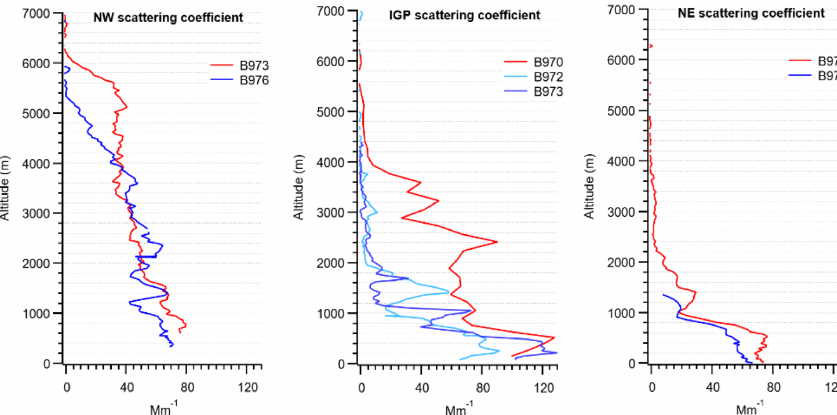
Figure 13. Aerosol scattering coefficient (Mm 1 ) in the vertical profile for NW India (Jaipur/Jodhpur: 26.91 ◦ N, 75.79 ◦ E/26.24 ◦ N, 73.02 ◦ E), IGP (Lucknow: 26.85 ◦ N, 80.95 ◦ E) and NE India (Bhubaneswar: 20.30 ◦ N, 85.83 ◦ E). The colours represent different science flights, with various progression into the monsoon